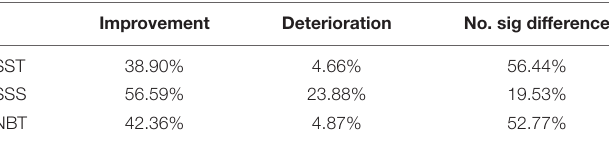
TABLE 3 | Significance of improvements in the 2011-2011 anomaly between CO6 and GloSea5 when compared to CMEMS. Improvement